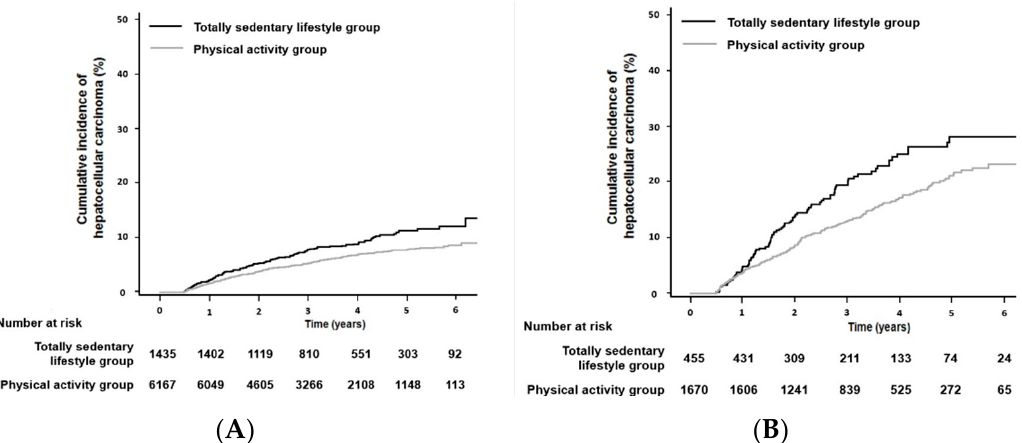
Figure 2. Kaplan–Meier estimate curve of HCC development in patients with chronic hepatitis B who were treated with entecavir or tenofovir. Kaplan–Meier estimate curve of HCC development for patients without liver cirrhosis ( A ) or patients with liver cirrhosis ( B ), according to physical activity (all, p < 0.001 by log-rank test).